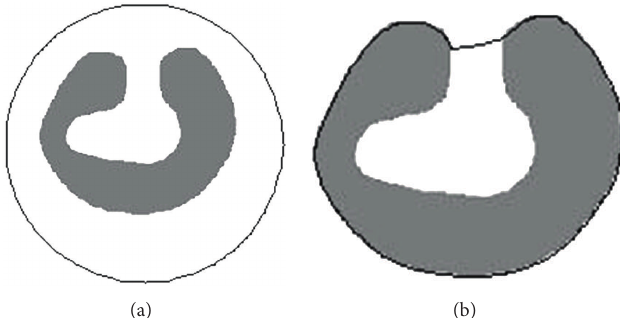
Figure 1: Extracted boundary with deep concavity using GVF based ACM. (a) Object and initial active contour. (b) Result after 150 iterations.